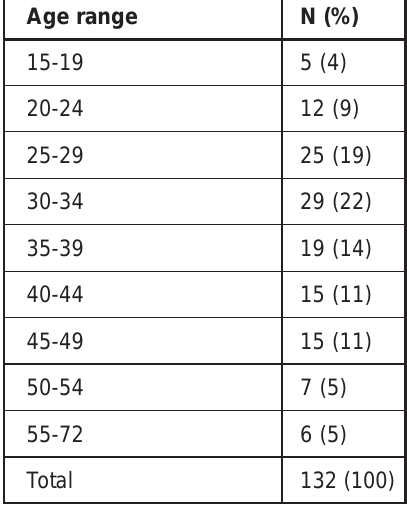
Table 2: Age-group distribution of patients ( n=132).